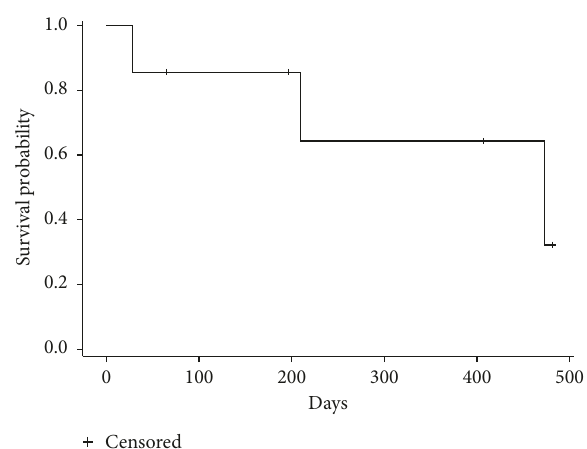
Figure 2: Kaplan–Meier estimates of overall survival in sarcoma in metastatic ( n � 7) setting.